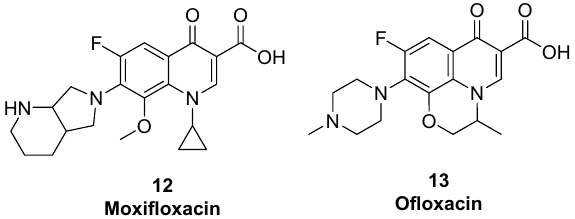
Figure 3. Chemical structures of moxifloxacin ( 12 ) and ofloxacin ( 13 ). Generated using ChemDraw 2021 (https:// perki nelme rinfo rmati cs. com/ produ cts/ resea rch/ chemd raw) 19